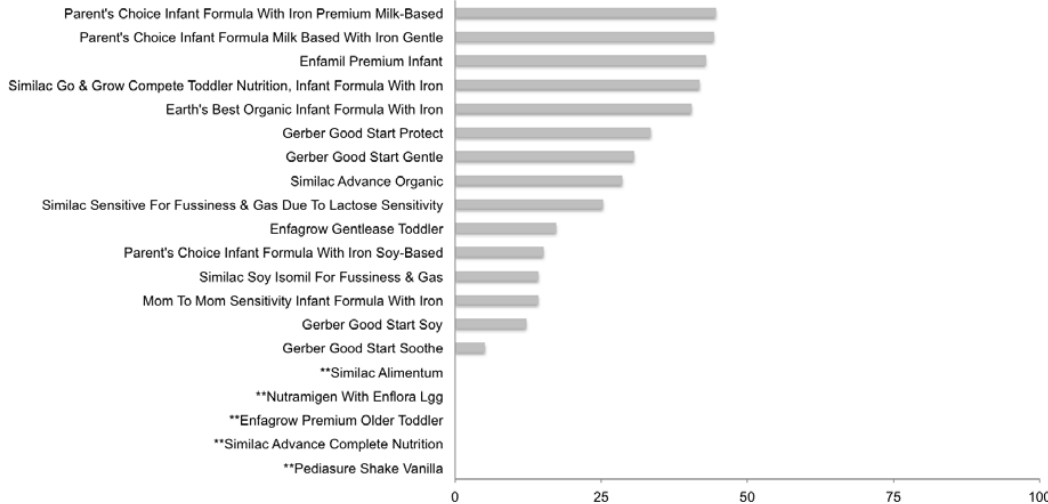
Figure 1. Percent of total calories from sugar: Formula. ** Unable to calculate in premixed, ready to use samples. Values were derived from the following equation: % Total Calories from sugar = [(Total Sugar Actual per serving × 4)/Total Calories per serving] × 100.